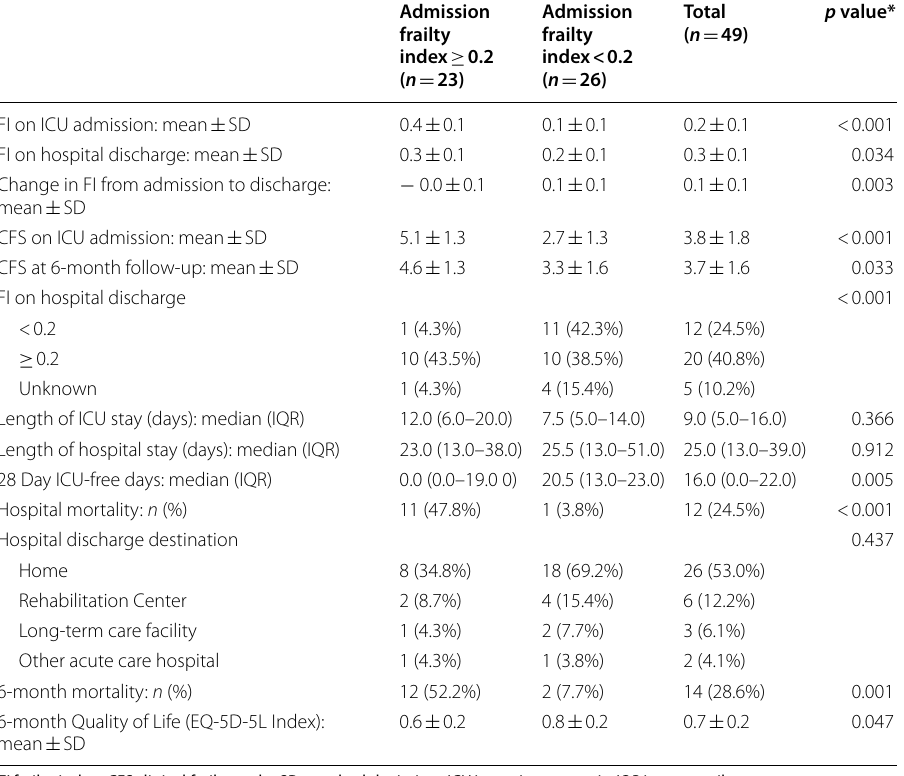
Table 4 Outcomes by admission frailty